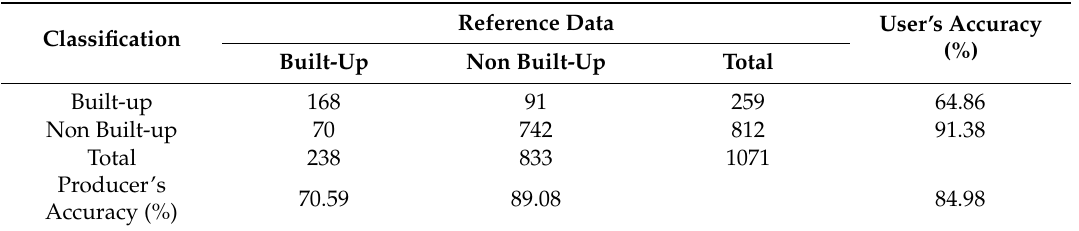
Table 3. Confusion matrix of built-up area extraction results from VANUI data in comparison with NLCD land cover